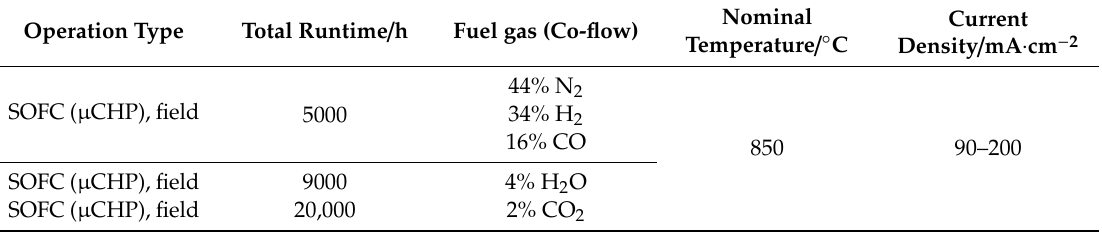
Table 1. Operating parameters for the stacks, from 5000 to 20,000 h. The nominal operating temperature and the current density are the same for all stacks.